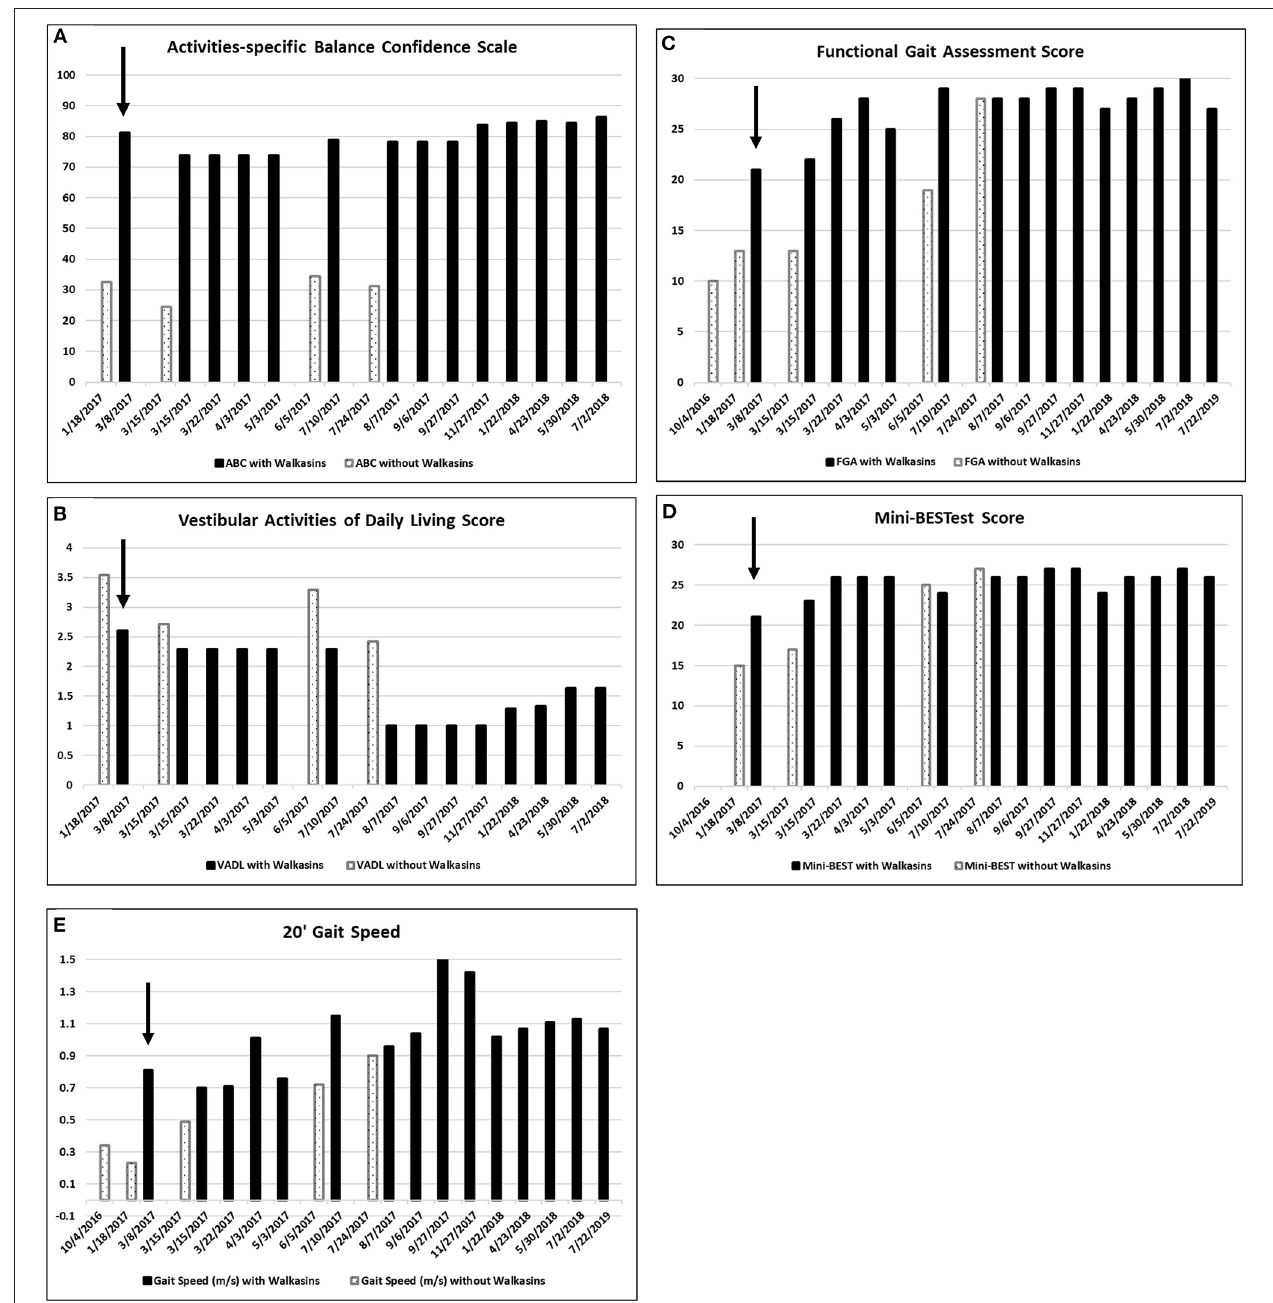
FIGURE 1 | (A) Scores on the Activities-specific Balance Confidence (ABC), (B) the Vestibular Activities of Daily Living (VADL), (the VADL and ABC were not administered on 7/22/2019), (C) Functional Gait Assessment (FGA), (D) Mini-BESTest, and (E) 20 ′ Gait Speed prior to and while wearing the Walkasins ® . Higher on the ABC, FGA, Mini-BESTest, and 20 ′ Gait speed and lower scores on the VADL are better. He started wearing the Walkasins ® on 3/8/2017 noted with an arrow ↓ . Note that occasionally the Walkasins ® device was turned off for a day and on those dates his perception of balance and functional ability decreased.